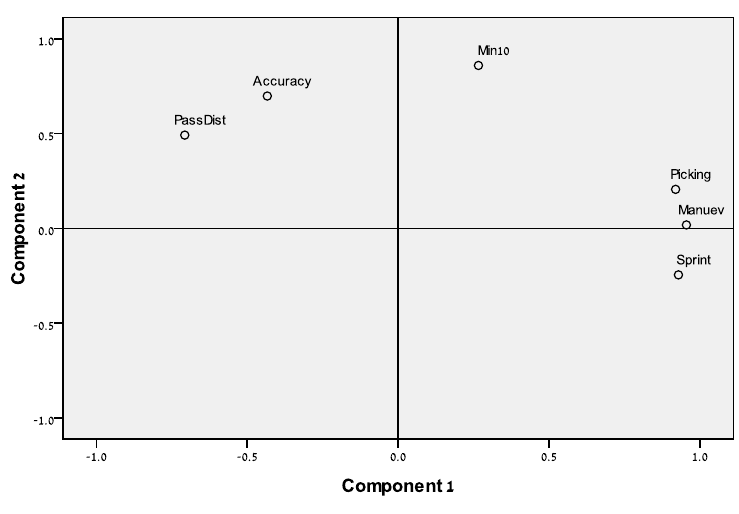
Figure 2 . Component plot in rotated space depicting factor loadings of